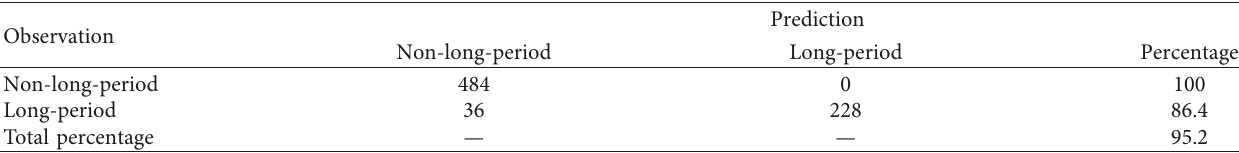
Table 3: Results for classification by using the proposed